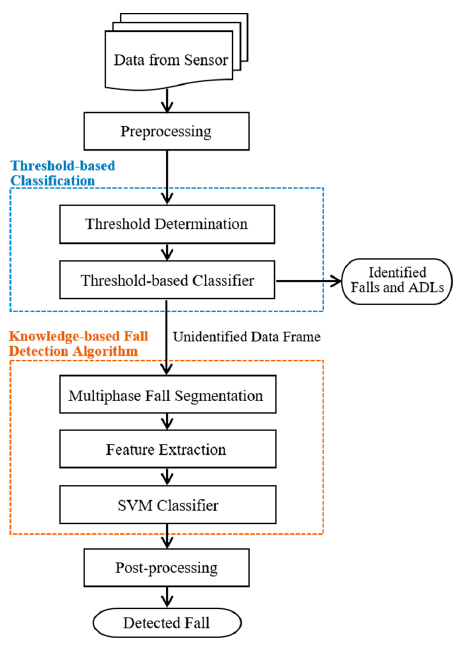
Figure 2. The functional diagram of the proposed fall detection algorithm.